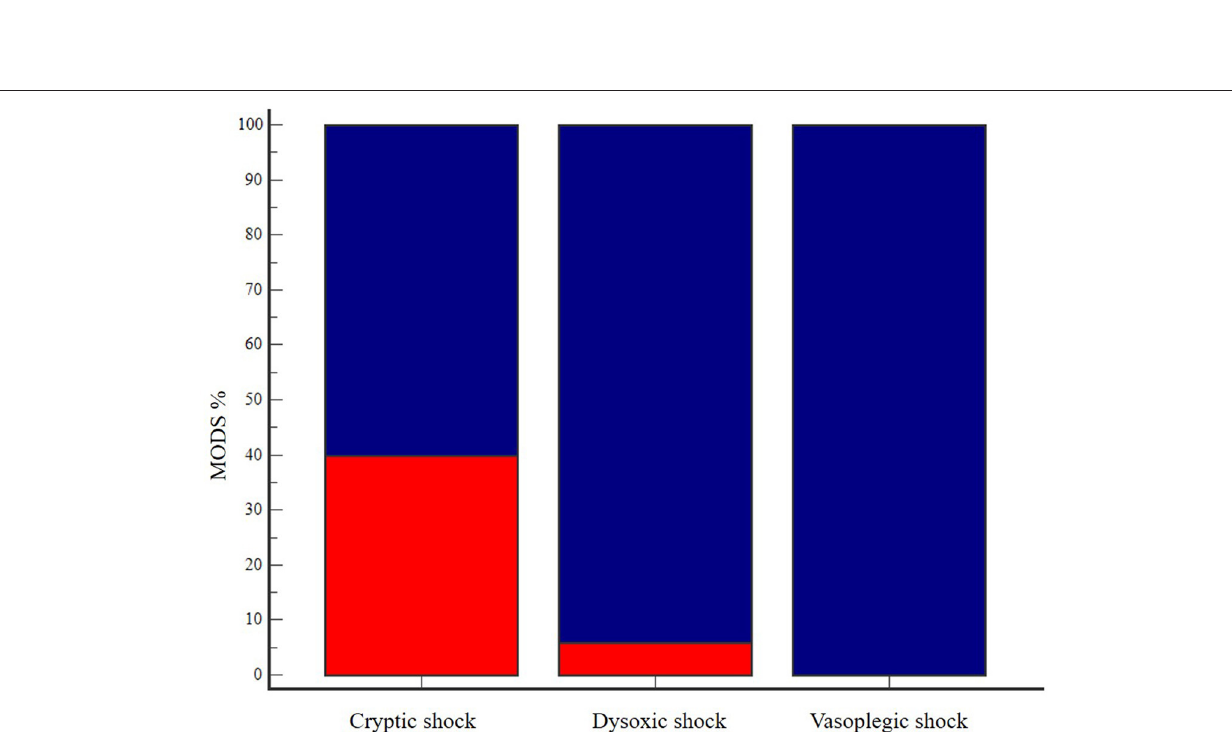
Frontiers in Veterinary Science |